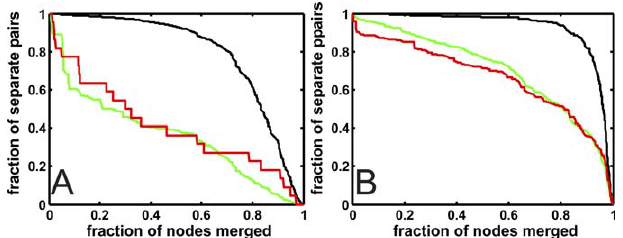
Figure 10. Modularity Analysis Using Information-Theoretic Clustering Fraction of pairs remaining separate as nodes are merged according to the information bottleneck clustering. (A) Largest connected component of a metabolic network evolved in a dynamic environment. Red line, synthetic lethal pairs; green line, knockdown suppressor pairs; black, random pairs. (B) Largest connected component of the yeast protein–protein interaction network. Colors as in (A), but compensatory pairs are dosage rescue